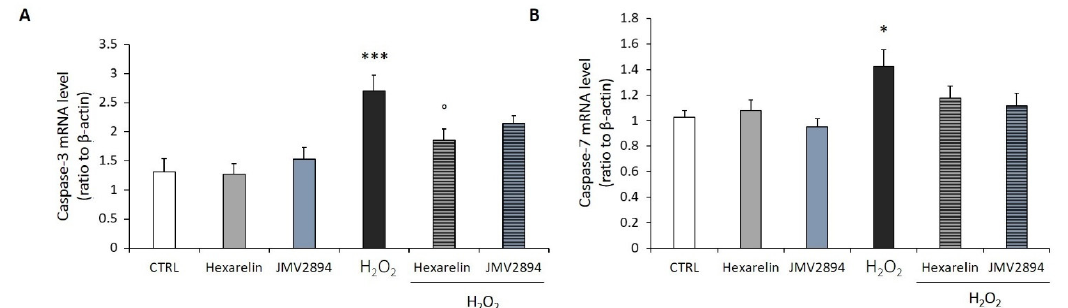
Figure 8. Caspase-3 and caspase-7 mRNA levels following incubation with H 2 O 2 and GHS. The SH-SY5Y SOD1 G93A were also co-incubated with 1 µ M GHS and 150 µ M H 2 O 2 for 24 h. Caspase-3